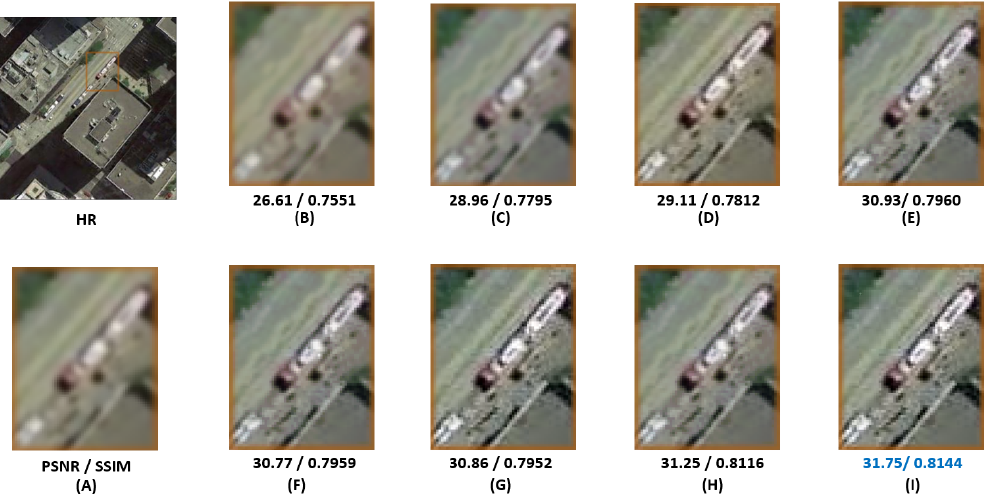
Figure 14. Comparison of values with different algorithms on the 3× “N0566” urban picture: ( A ) LR; ( B ) bicubic; ( C ) SRCNN; ( D ) FSRCNN; ( E ) VDSR; ( F ) EDSR; ( G ) LapSRN; ( H ) SRGAN; ( I ) ours.